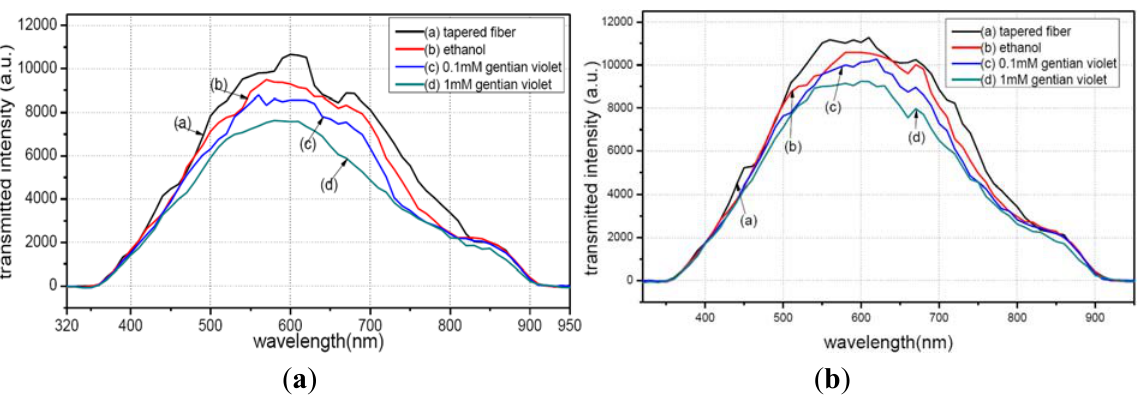
Figure 13. Transmittance of the modified fiber by MPTMS in two tests. ( a ) 1st test ( b ) 2nd test.